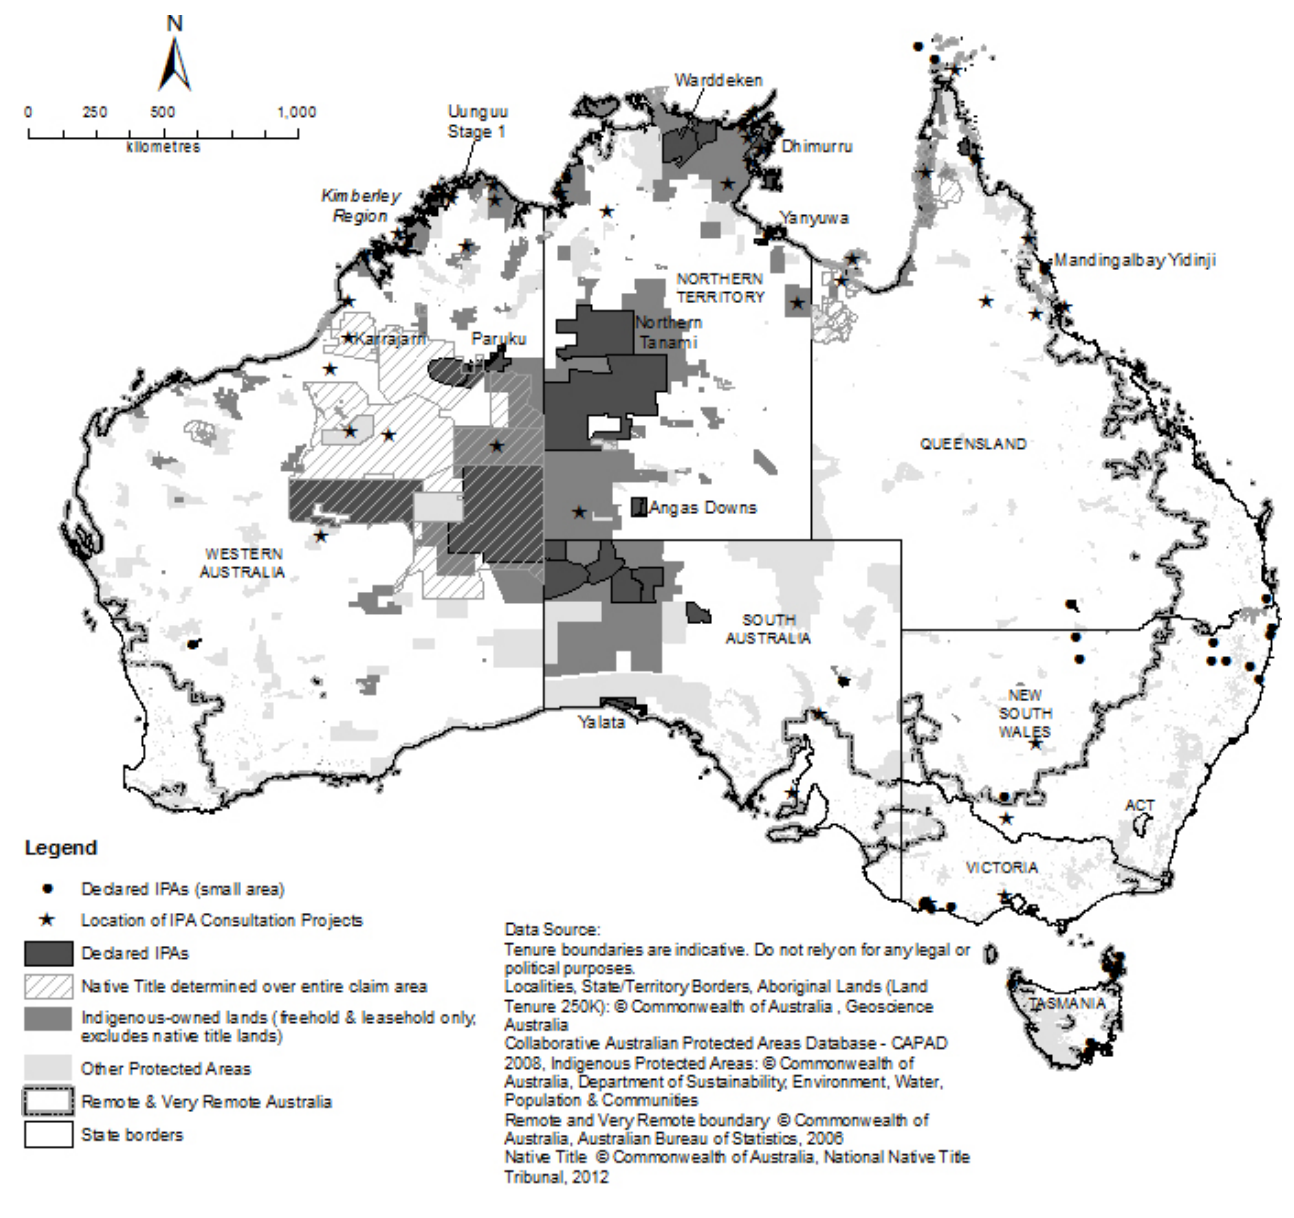
Fig. 1 . Location of declared indigenous protected areas (IPA) and IPA Consultation Projects (proposals), May 2012, with names of IPAs and proposals mentioned in the